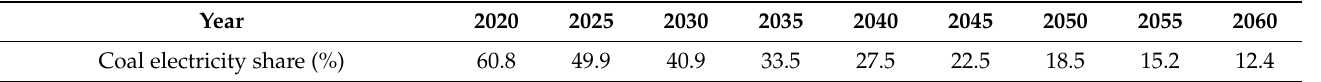
Table 13. The baseline scenario for coal electricity share in the